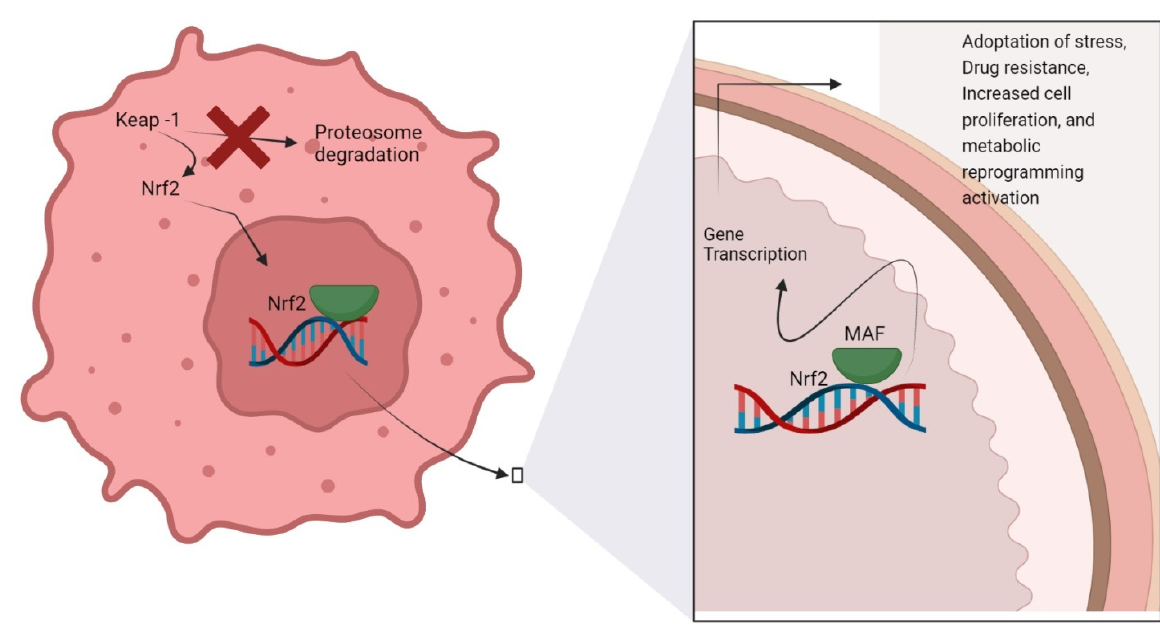
Figure 1. Nrf2 activation/inhibition in cancer cells. Various molecular mechanisms in cancer cells constitute activation of Nrf2, leading to gene expression associated with progression of tumors. The resultant effect is in the form of activation of metabolic reprogramming, enhanced cell proliferation, drug resistance, and adaptation to stress. Nrf2 antioxidant activation also induces an imbalance in the carbon metabolism in cancer. Keap-1; kelch-like ECH-associated proteins, Nrf2; nuclear factor erythroid 2-related factor 2, MAF; musculoaponeurotic fibrosarcoma